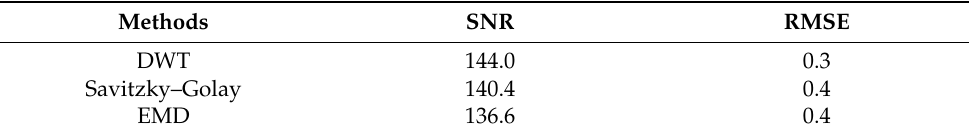
Figure 2. Excitation fluorescence spectra before and after noise removal based on three different denoising methods: ( a ) with soft threshold quantization under db10 wavelet at the third level (discrete wavelet transformation (DWT)), ( b ) with the Savitzky–Golay Filter, and ( c ) with the empirical mode decomposition (EMD) filter. Table 2. Comparison of denoising effects based on three different methods.